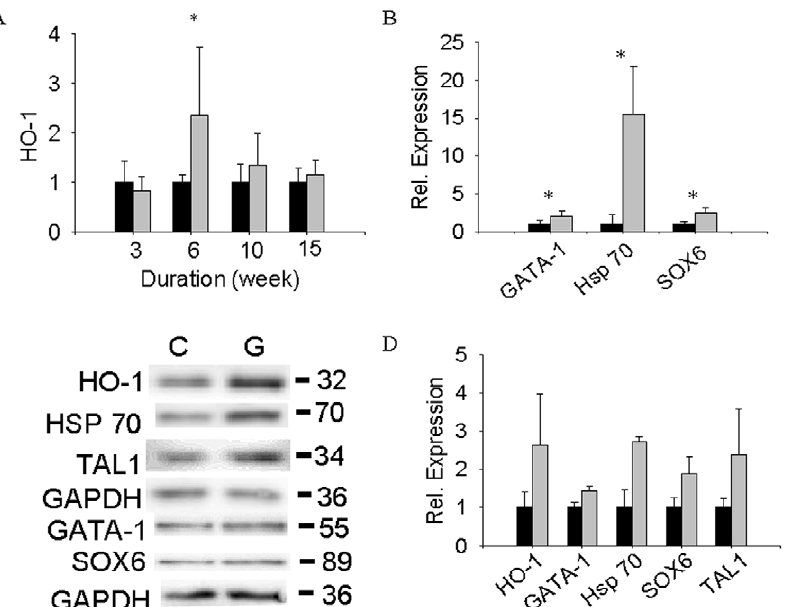
Figure 3. Splenic expression levels of HO-1, Hsp70, Gata-1, Sox6, and Tal1. (A) QPCR of HO-1 (mean 6 sd., n=3). (B) qPCR of Gata-1, Hsp70, and Sox6 (mean 6 sd., n=3). (C) Immunoblotting patterns of HO-1, Hsp70, Gata-1, Sox6 and Tal1 proteins in control (C) and garlic (G) spleen samples (week 15) with glyceraldehydes 3-phosphate dehydrogenase (GAPDH) as the reference protein. The numbers are in kilodaltons. (D) Quantification of results in C (mean 6 s.e.m., n=3). Expression is calculated relative to the control samples of each time point (A) or of week 15 (B, D). The fold increase in garlic-fed samples was calculated as [ratio of (protein X/GAPDH) in garlic-fed mouse spleen]/[ratio of (protein X/GAPDH) in control mouse spleen]. (Statistics: *, p , 0.05 by student’s t test). Black bars, control diet; gray bars, garlic diet.